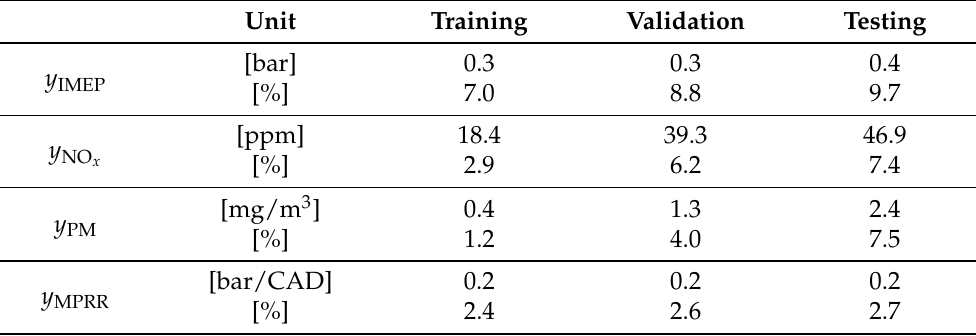
Table 3. RMSE and normalized RMSE of DNN model vs. Experiment—RMSE: Root Mean Square Error, IMEP: indicated mean effective pressure, FQ: Fuel Quantity. PM: Particle Matter, MPRR: maximum pressure rise